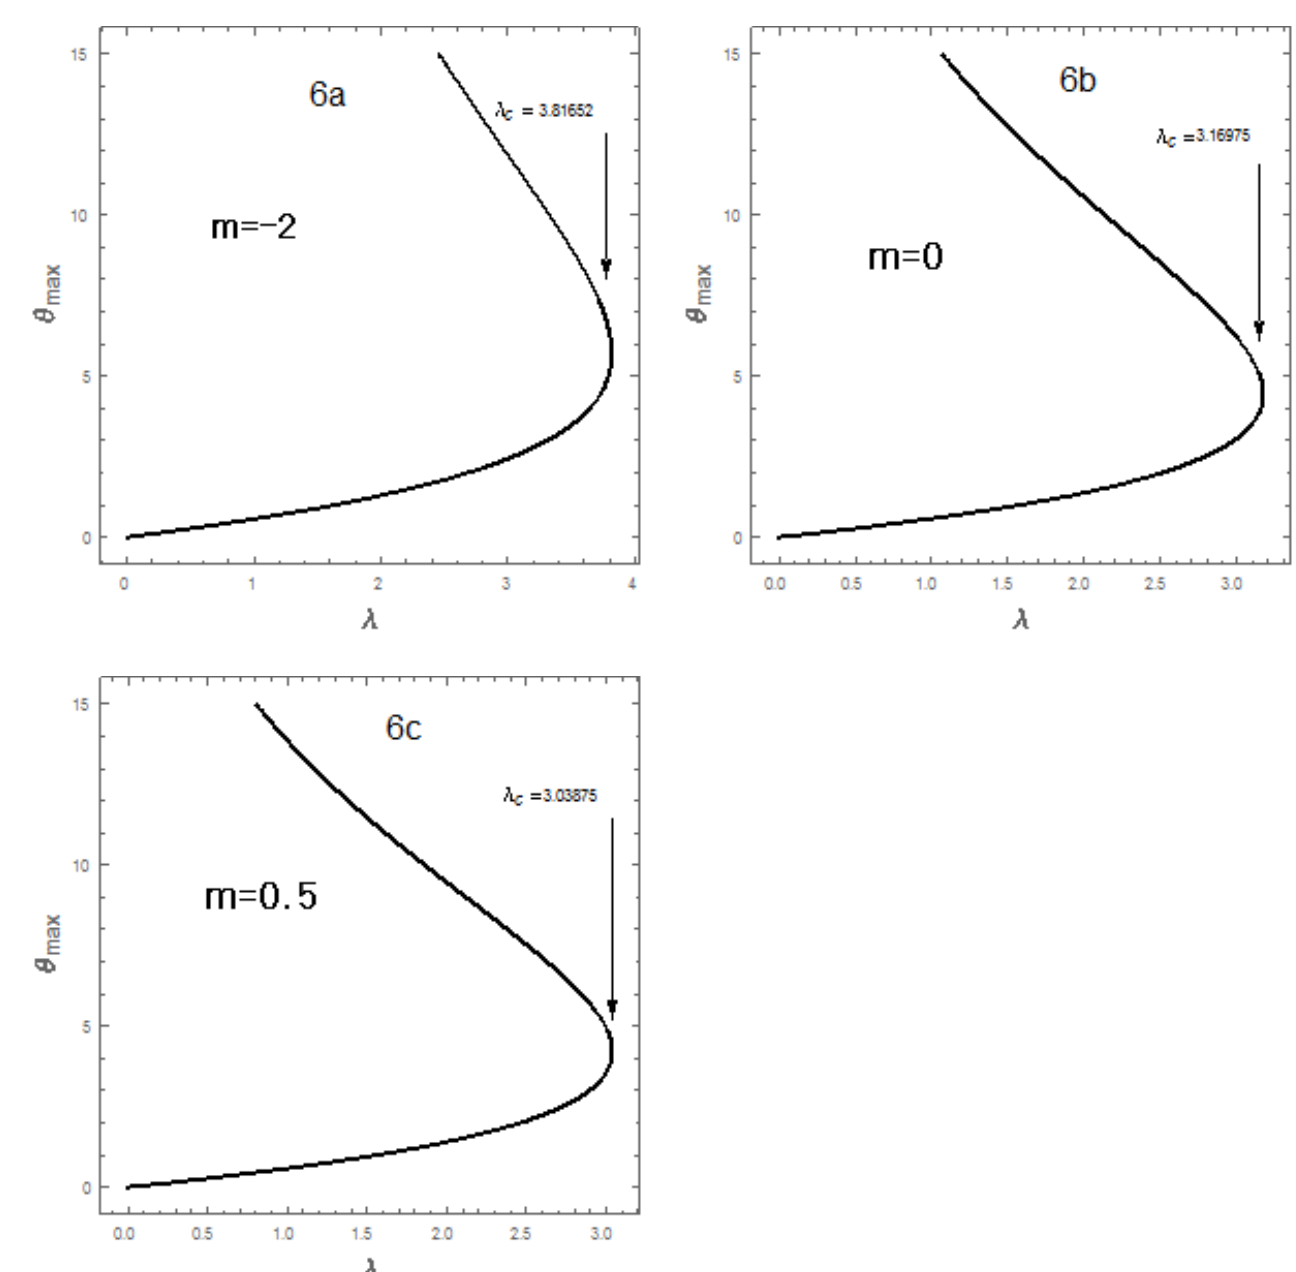
Figure -5. Variations in Frank-Kameneskii parameter.